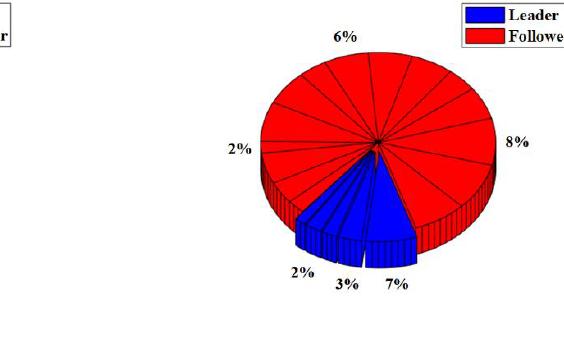
Table 7. The performance of the DDPOS